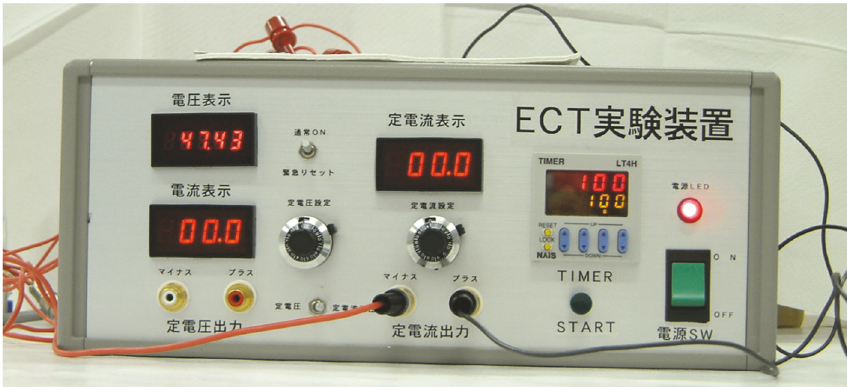
Figure 1: Electrochemical therapy equipment (Sunny Health Co, Tokyo,